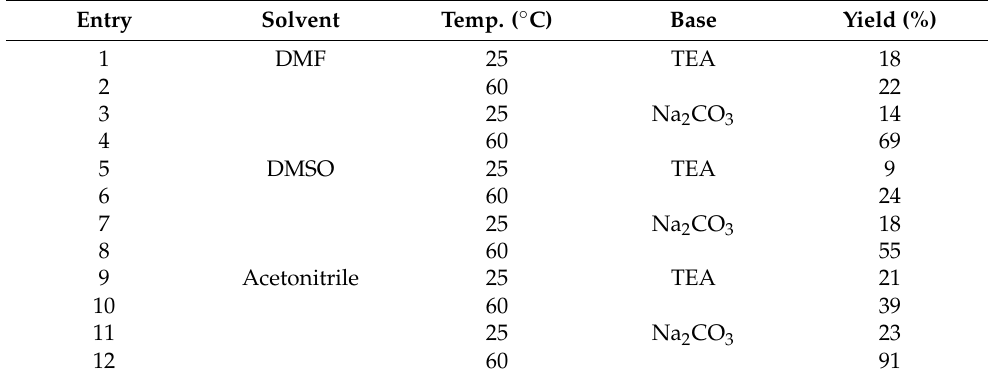
Table 3. Optimization of the substitution reaction with diethyl iminodiacetate to form derivative 6a .